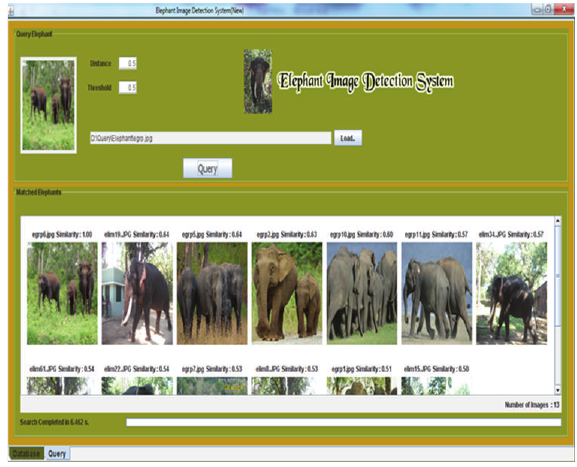
Figure 8: Retrieved elephant group image.